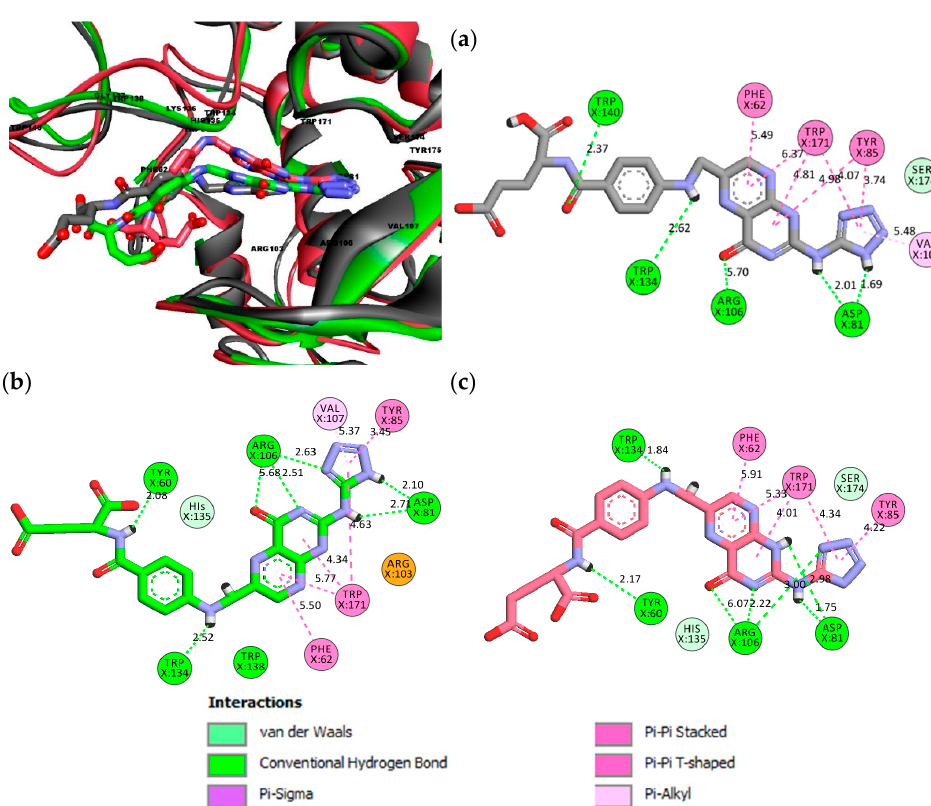
Figure 10. FOL03 orientation and its interactions with FR α during MD simulations at 68.24 ns ( a ), 86.20 ns ( b ), and 91.57 ns ( c ). This model demonstrates the behavior of the FOL03 interaction with ASP81 and the location of the amino acids in the active site of the FR α .